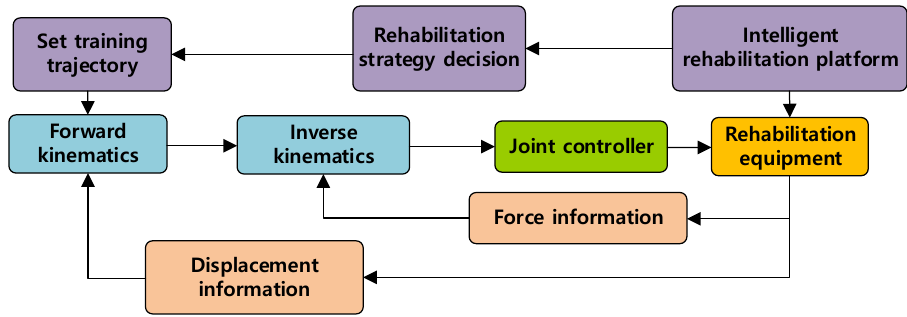
Figure 8. System control diagram of the semi-passive, semi-active training mode.